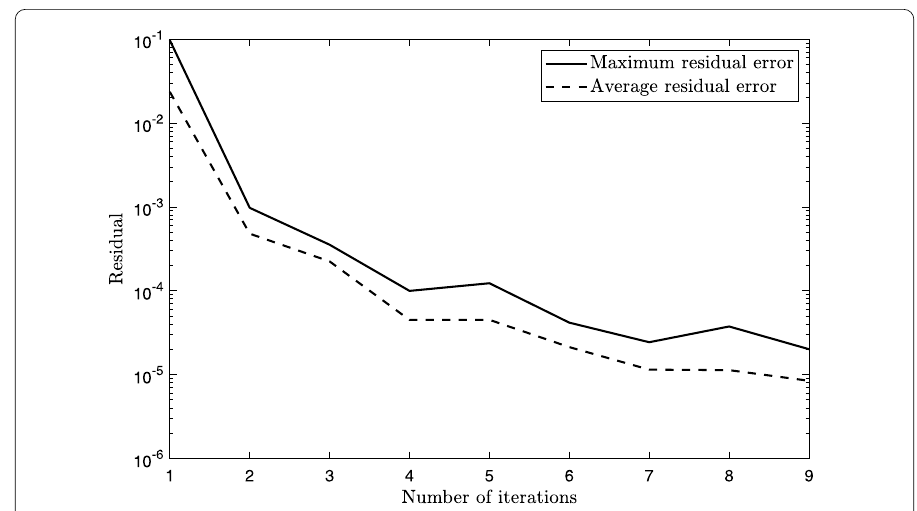
Figure 7 Maximal and average residuals per iteration of adaptive greedy